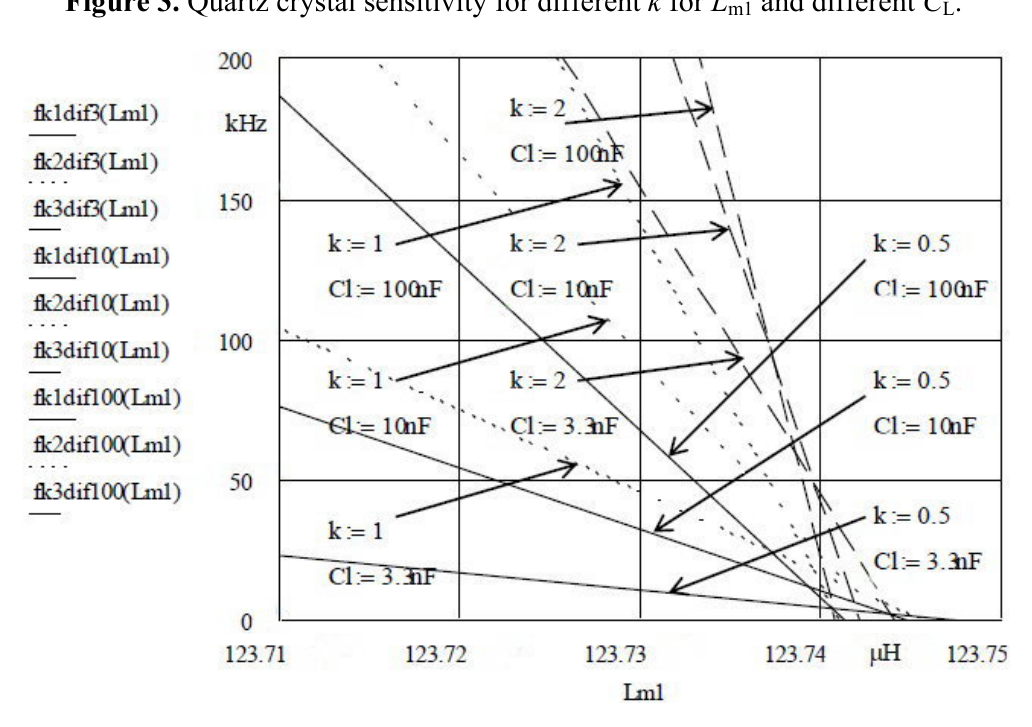
Figure 3. Quartz crystal sensitivity for different k for L